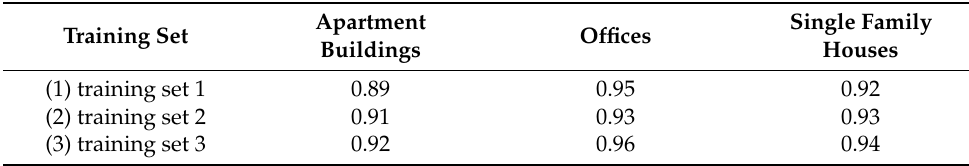
Table 3. R 2 in the test set for different building types.